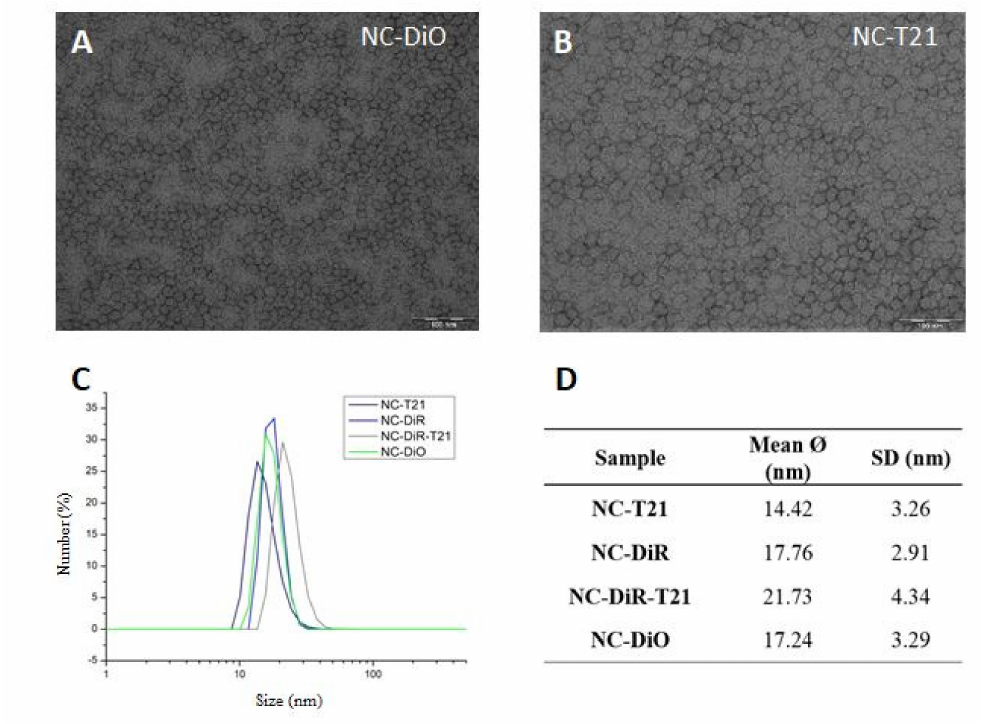
Figure 1. Characterization of the nanocapsules. ( A , B ) representative TEM micrographs (scale bar: 100 nm); ( C ) particle size distributions by DLS; ( D ) statistical analysis of different